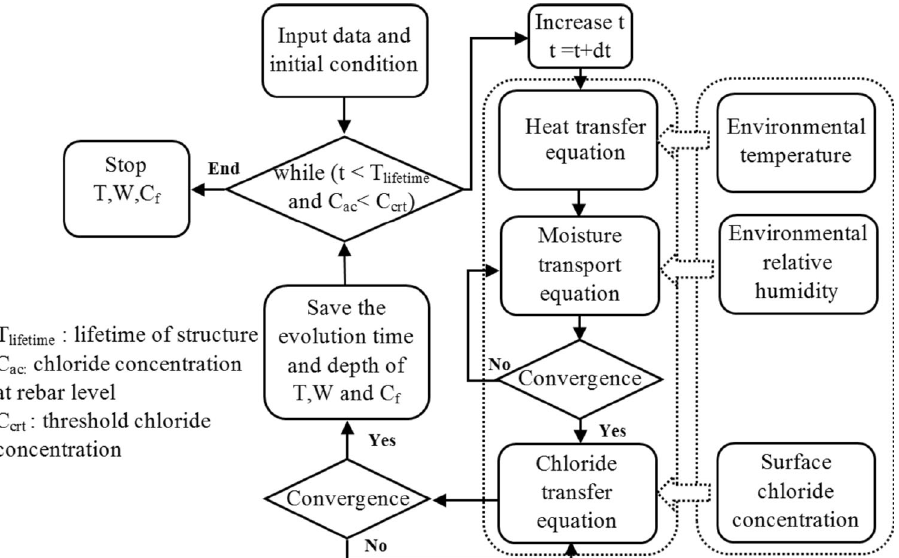
Fig. 1 Algorithm for calculating temperature, moisture content and chloride profiles.